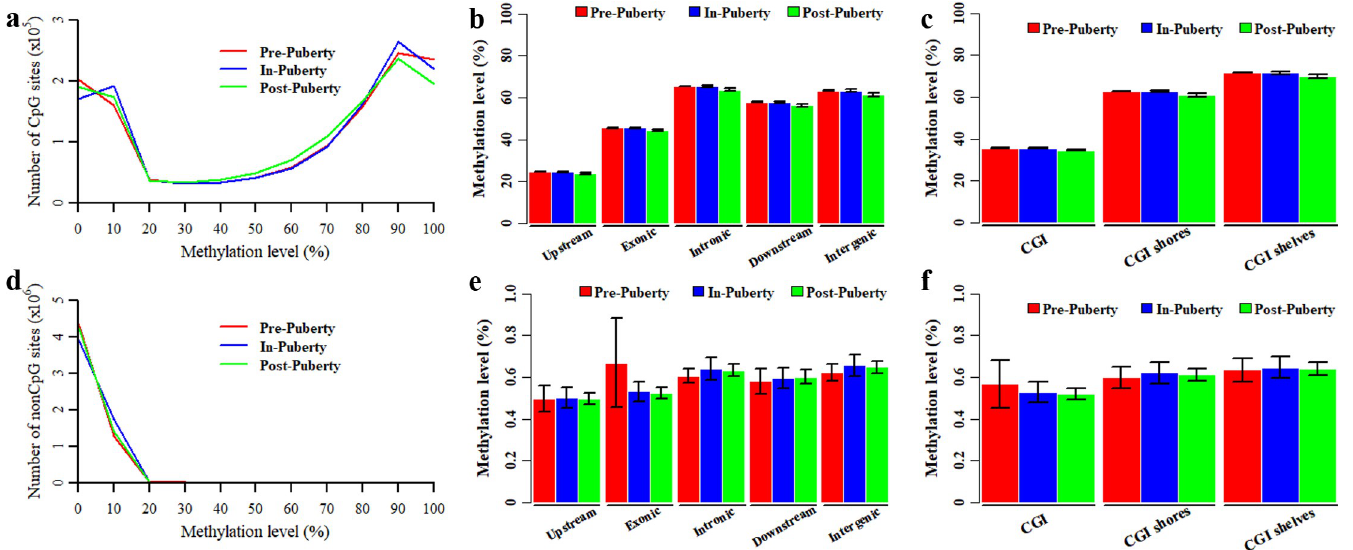
Fig 1. Genome-wide DNA methylation of pituitary tissues during the timing of puberty. Distribution of methylation levels in CpG ( a ) and CpH ( d ) context. Average methylation levels of CpGs in gene- ( b ) and CGI-related regions ( c ). Average methylation levels of CpHs in gene- ( e ) and CGI-related regions ( f ). https://doi.org/10.1371/journal.pone.0212630.g001 P < 2.22 × 10 − 16 ) and CGIs (Pearson’s correlation coefficient = 0.27, P < 2.22 × 10 − 16 ) (Fig 2A and S1 Table), but negatively correlated with the densities of genes (Pearson’s correlation coef- ficient = -0.12, P < 2.22 × 10 − 16 ) (Fig 2A and S1 Table). In the CpH context, however, the Pear- son’s correlation coefficient was 0.57, 0.80 and 0.58 for Pre- vs. In-, In- vs. Post-, and Pre- vs. Post-stage in CpH context, respectively (Fig 2B and S1 Table). The Pearson’s correlation coeffi- cient was 0.10 ( P < 2.22 × 10 − 16 ), 0.15 ( P < 2.22 × 10 − 16 ) and 0.15 ( P < 2.22 × 10 − 16 ) between